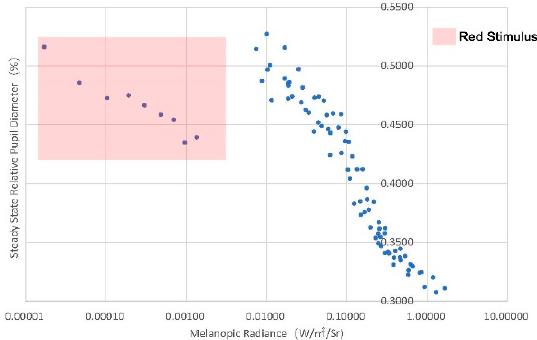
Figure 8. Measured Steady-State of Pupil Diameter vs. Melanopic Radiance of Stimulus (log scale).